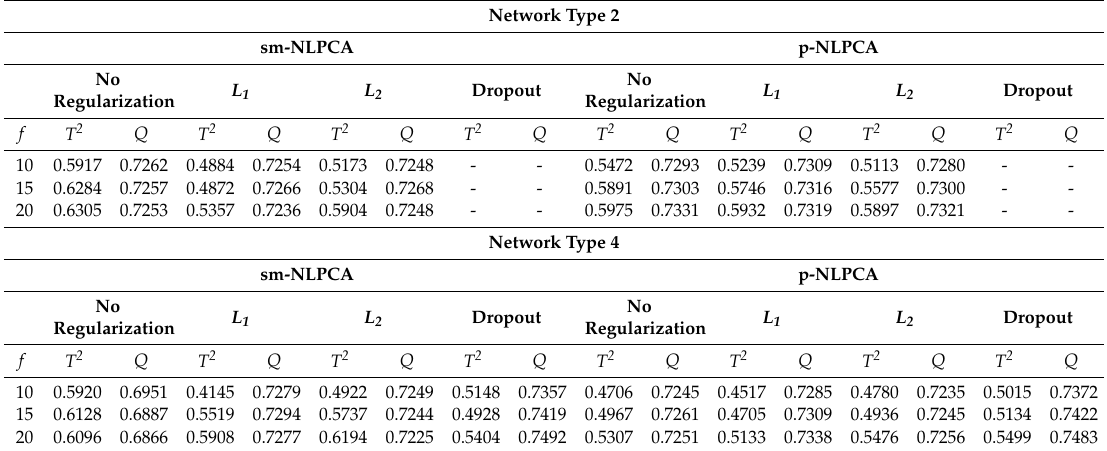
Table 9. Process monitoring results with network regularization and adjusted upper control limits (FAR = 0.01 for the normal test